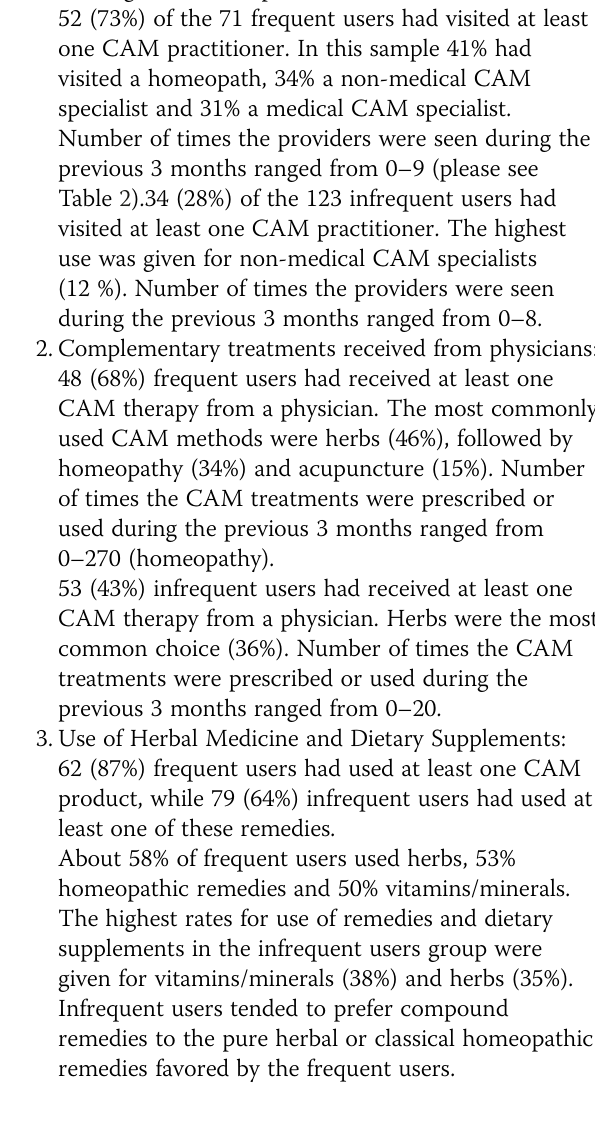
Table 3 Reasons for CAM usage (exemplary items per page) Breast cancer sample Internet